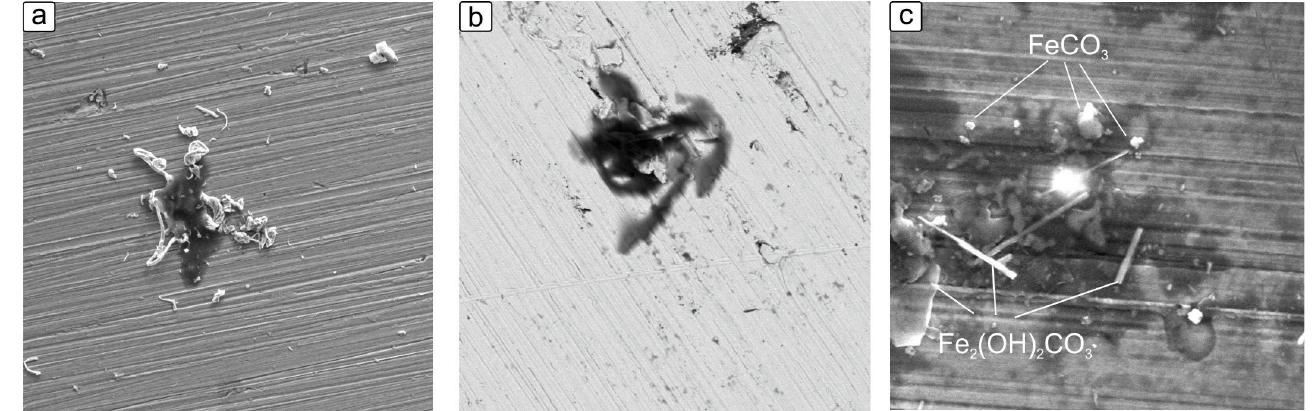
Figure 11. Indicative SEM images for ( a ) salt precipitation, ( b ) FeCO 3 nodules and ( c ) plate-like corrosion products ascribed to Fe 2 (OH) 2 CO 3 phase.